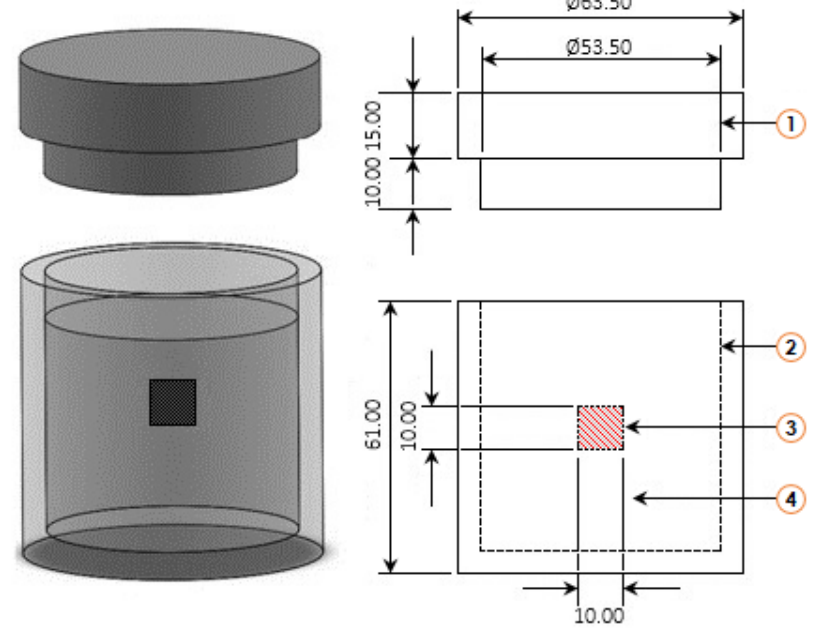
Figure 1. Schematic and cross-sectional representation of the AISI 316L stainless steel container used for the thermochemical diffusion process. (1: lid with a relief hole; 2: powder mixture (B 4 C + KBF 4 + SiC); 3: substrate; 4: steel container) (the scale is in millimeters).